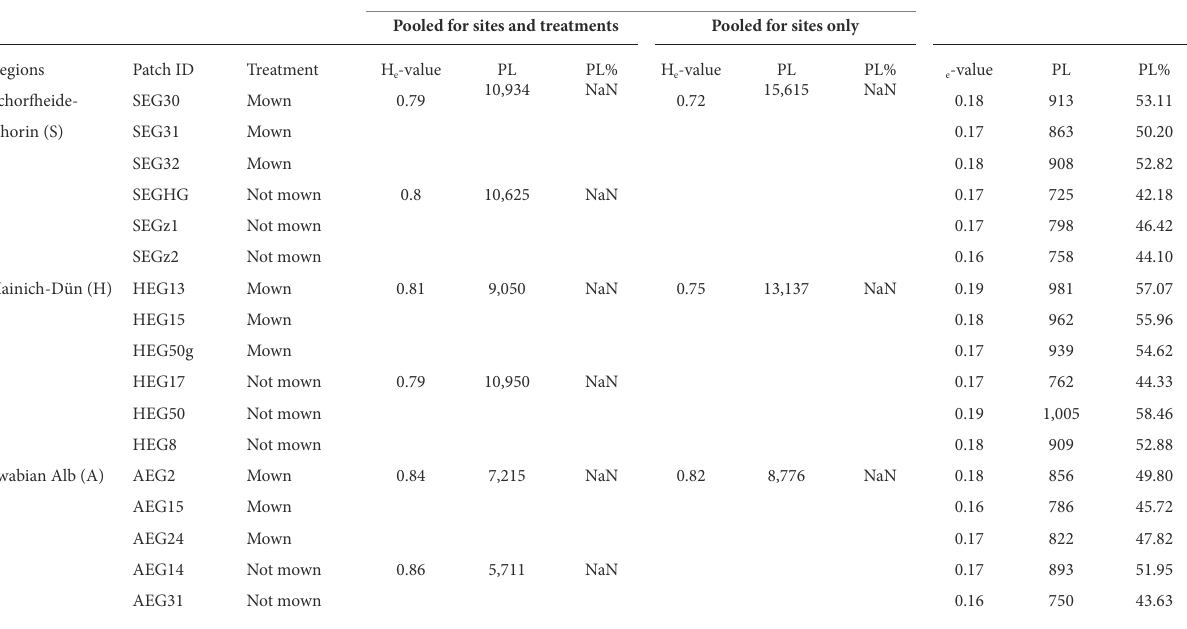
mRNA-GBS Pooled for sites and